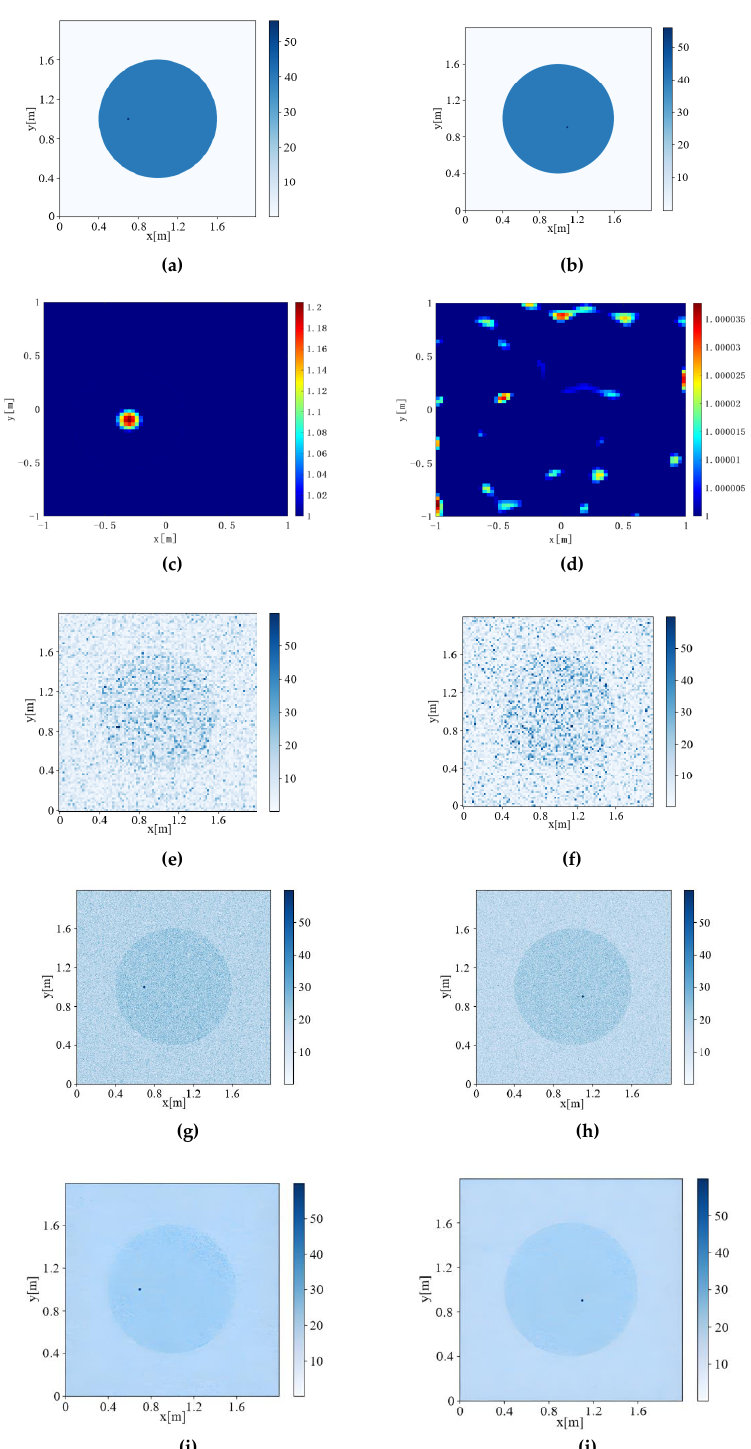
Figure 9. Inversion results of Inversion Ratio from 1:50 to 1:60. ( a ) Model diagram of Inversion Ratio = 1:50. ( b ) Model diagram of 𝐼𝑛𝑣𝑒𝑟𝑠𝑖𝑜𝑛 𝑅𝑎𝑡𝑖𝑜 = 1:60. ( c ) Contrast Source Inversion results of 𝐼𝑛𝑣𝑒𝑟𝑠𝑖𝑜𝑛 𝑅𝑎𝑡𝑖𝑜 = 1:50. ( d ) Contrast Source Inversion results of 𝐼𝑛𝑣𝑒𝑟𝑠𝑖𝑜𝑛 𝑅𝑎𝑡𝑖𝑜 = 1:60. ( e ) Deep Convolutional Inversion results of Inversion Ratio = 1:50. ( f ) Deep Convolutional Inversion results of Inversion Ratio = 1:60. ( g ) Joint driven inversion results of Inversion Ratio =1:50 ( h ) Joint driven inversion results of Inversion Ratio =1:60 ( i ) Joint-Driven Super-Resolution inversion results of Inversion Ratio = 1:50. ( j ) Joint-Driven Super-Resolution inversion results of Inversion Ratio =